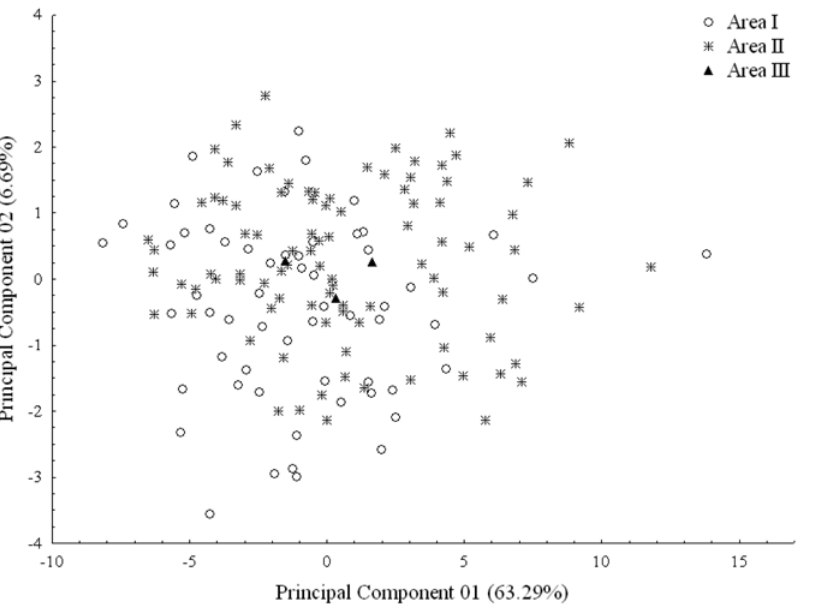
Fig. 5 - Graphic dispersion of the population Tetrapedia diversipes in relation to Cartesian axes established by the first two principal components